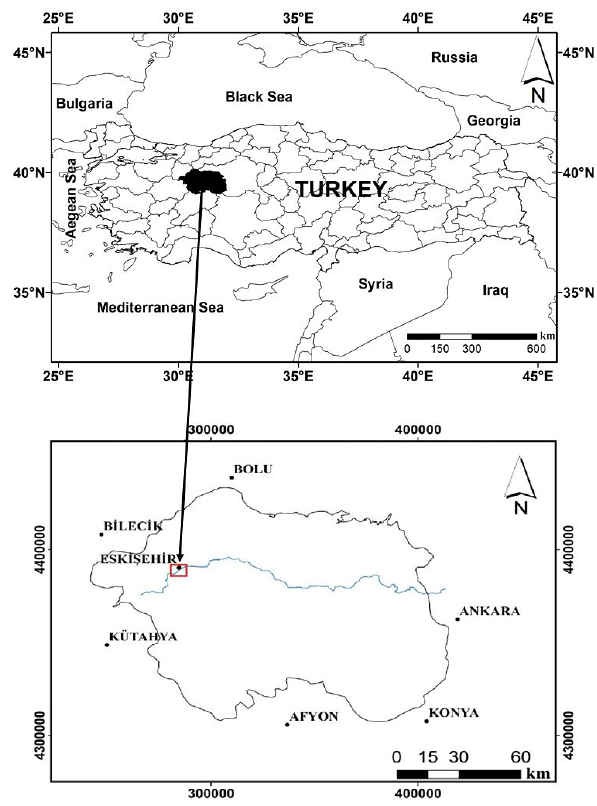
Figure 1. Site location map of the study